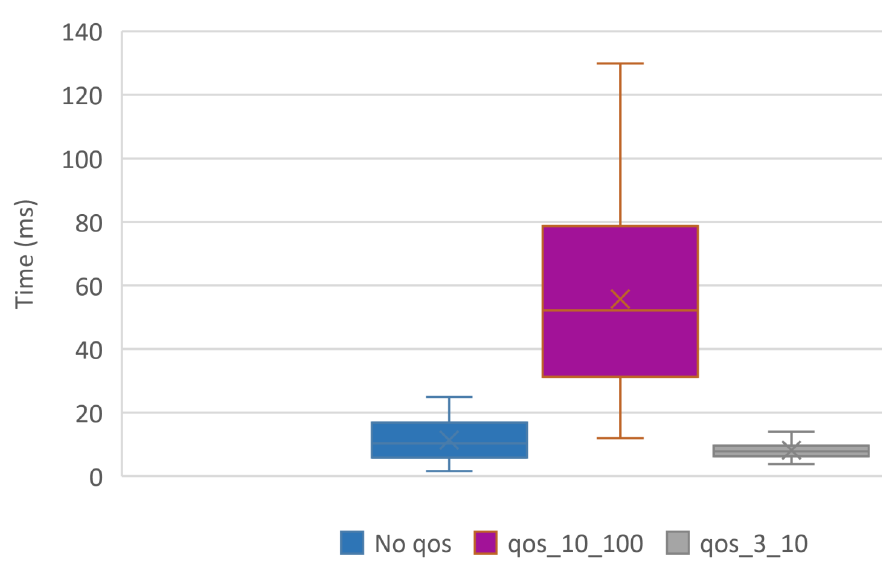
Figure 19. Single hop latency.